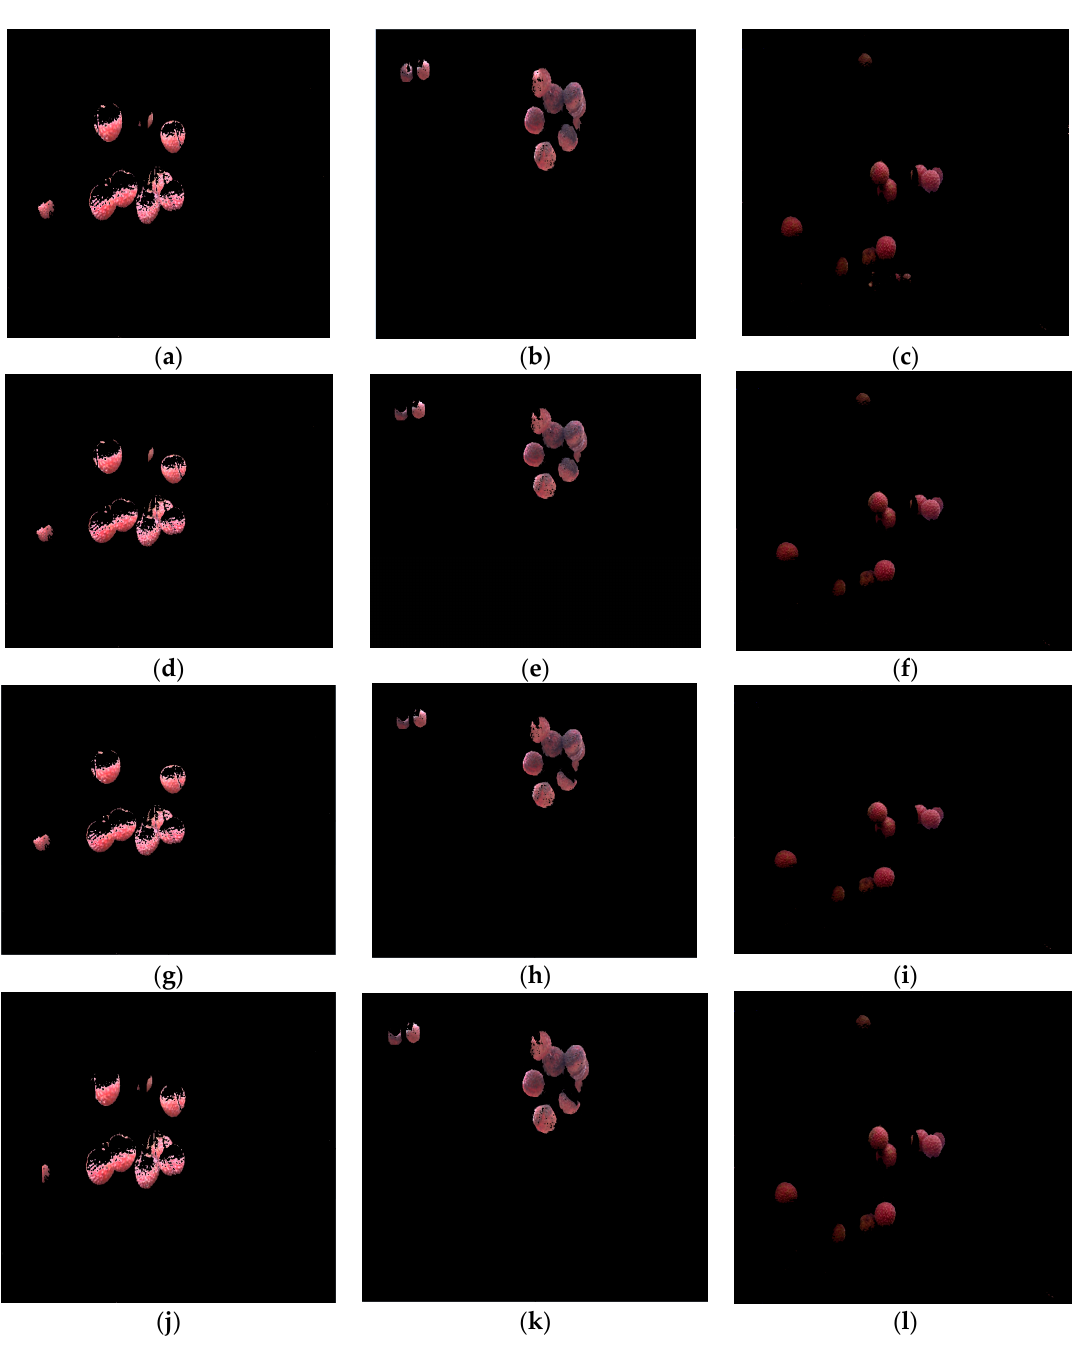
Figure 11. Original litchi color images under different illumination conditions. ( a ) Original litchi color image under front-lighting conditions; ( b ) Original litchi color image under back-lighting conditions; ( c ) Original litchi color image under cloudy day conditions.